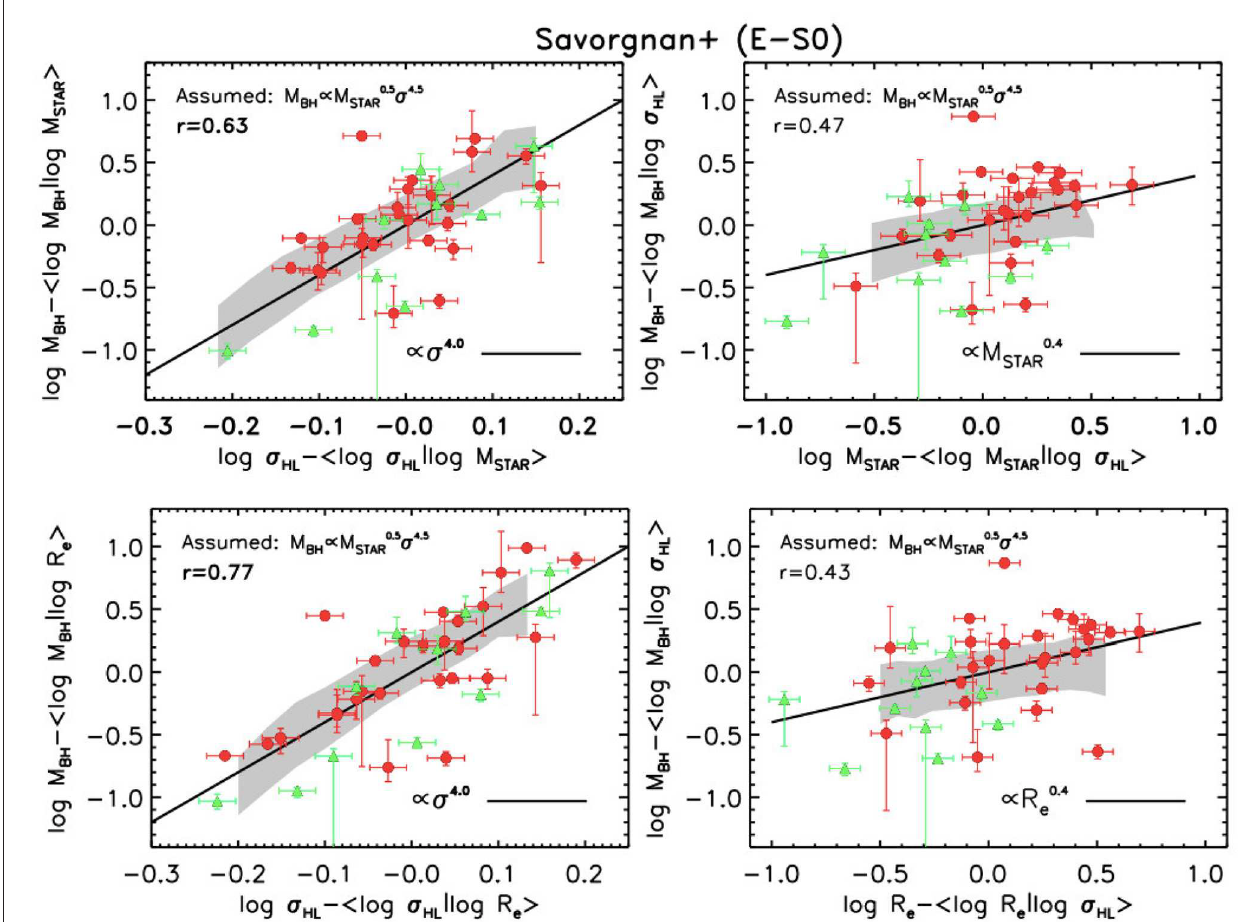
FIGURE 3 | Figure 5 from Shankar et al. [44] showing correlations between residuals. Correlations with velocity dispersion (left panels) appear to be stronger than other relations. The data is from the sample of Savorgnan et al. [ 60].